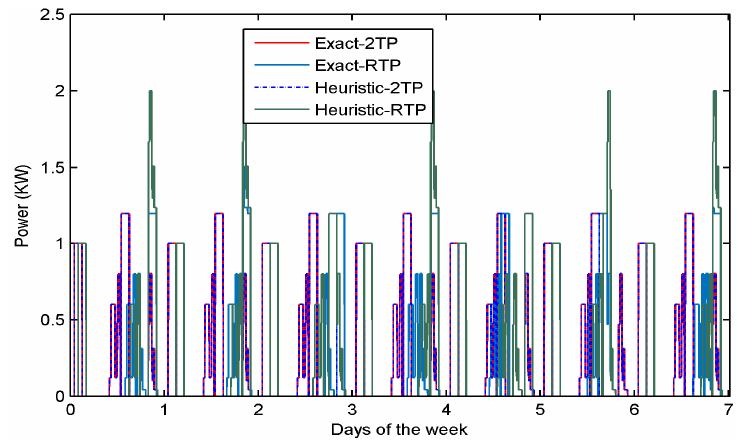
Figure 10. Power distribution across the first week of July 2014, representing summer period.